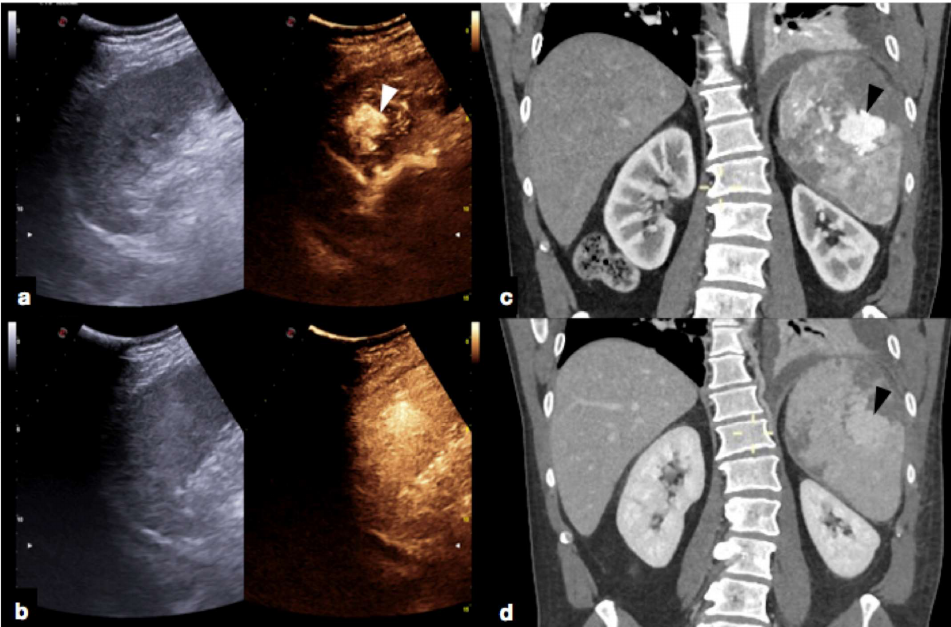
Figure 19. High grade traumatic splenic injury with vascular complication. Arterial ( a ) and venous ( b ) phase CEUS examination in a 25−year-old patient admitted at the emergency department for blunt abdominal trauma, showing multiple splenic lacerations and a voluminous arteriovenous fistula (white arrowhead). Subsequent arterial ( c ) and portal vein ( d ) phase contrast-enhanced CT scan further confirmed the diagnosis (black arrowhead).